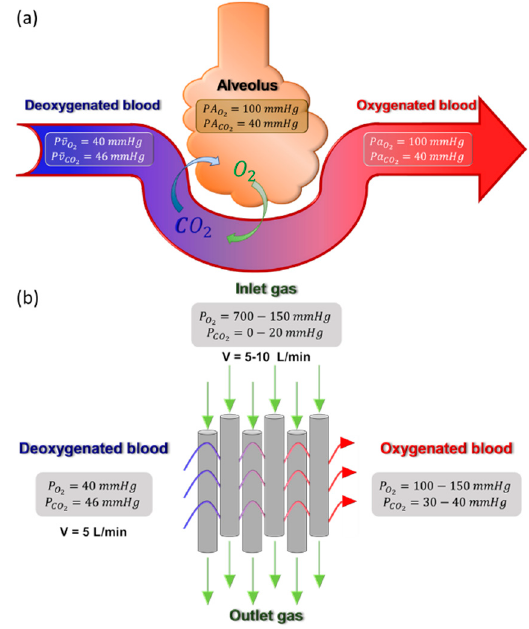
Figure 4. Illustration of gas transfer mechanism in ( a ) the human lung; and ( b ) membrane-based blood oxygenation device.